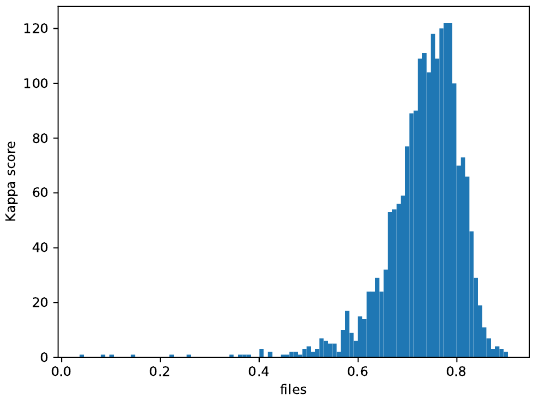
Figure 8. Histogram of kappa score between notes detected by Tony and our